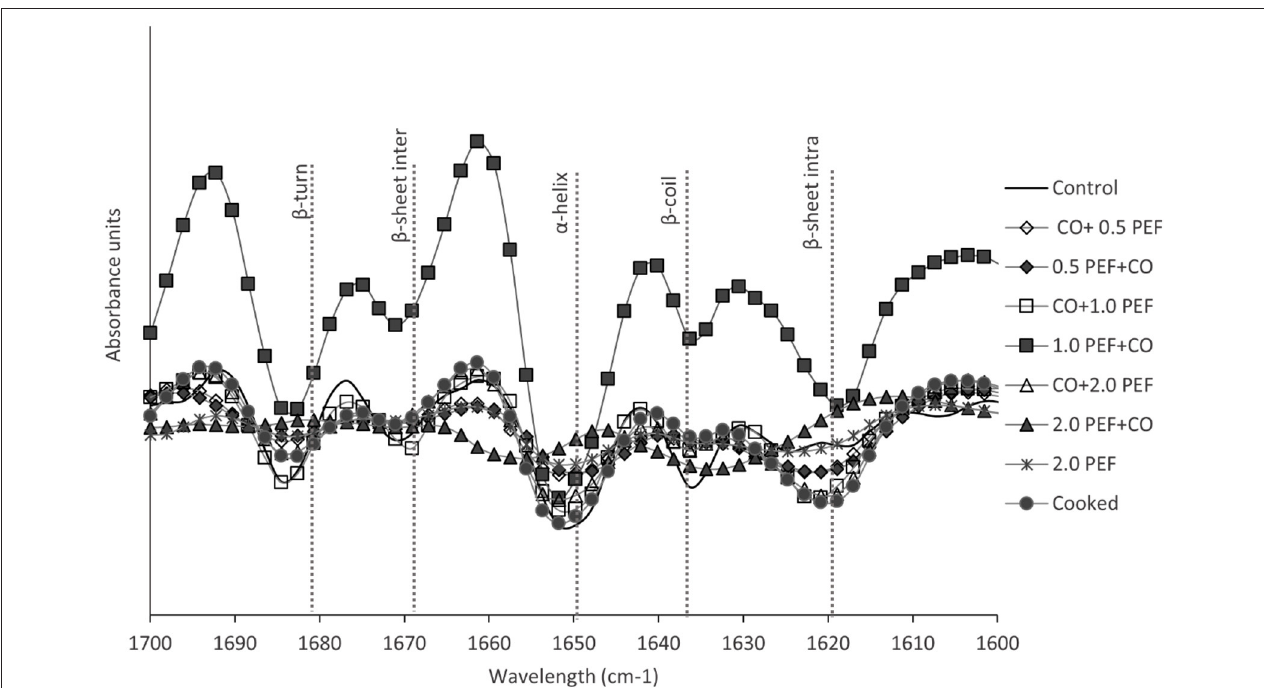
FIGURE 3 | Second-derivative Fourier transform IR (FTIR) of freeze-dried samples under different pretreatment conditions, including the control sample.